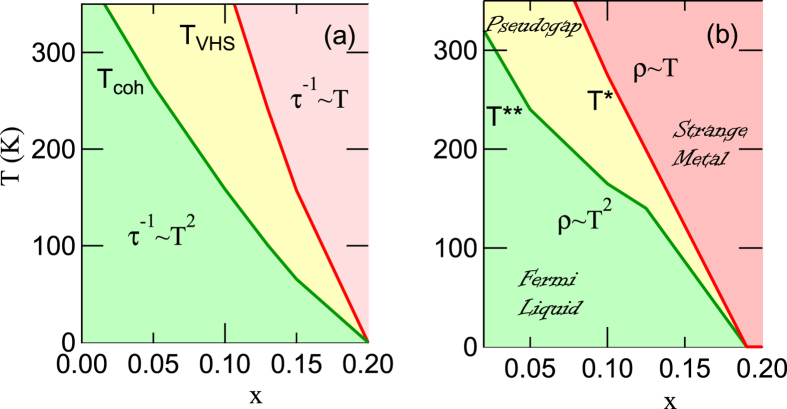
Phase diagram of LSCO, comparing VHS-phase diagram (a) with experimental pseudogap phase diagram9 (b).